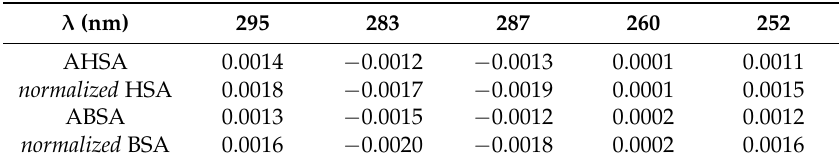
Table 1. Second derivative values (d 2 A/d λ 2 ) for wavelength range of the protein chromophores: tryptophanyl (Trp), tyrosyl (Tyr), and phenylalanine (Phe).